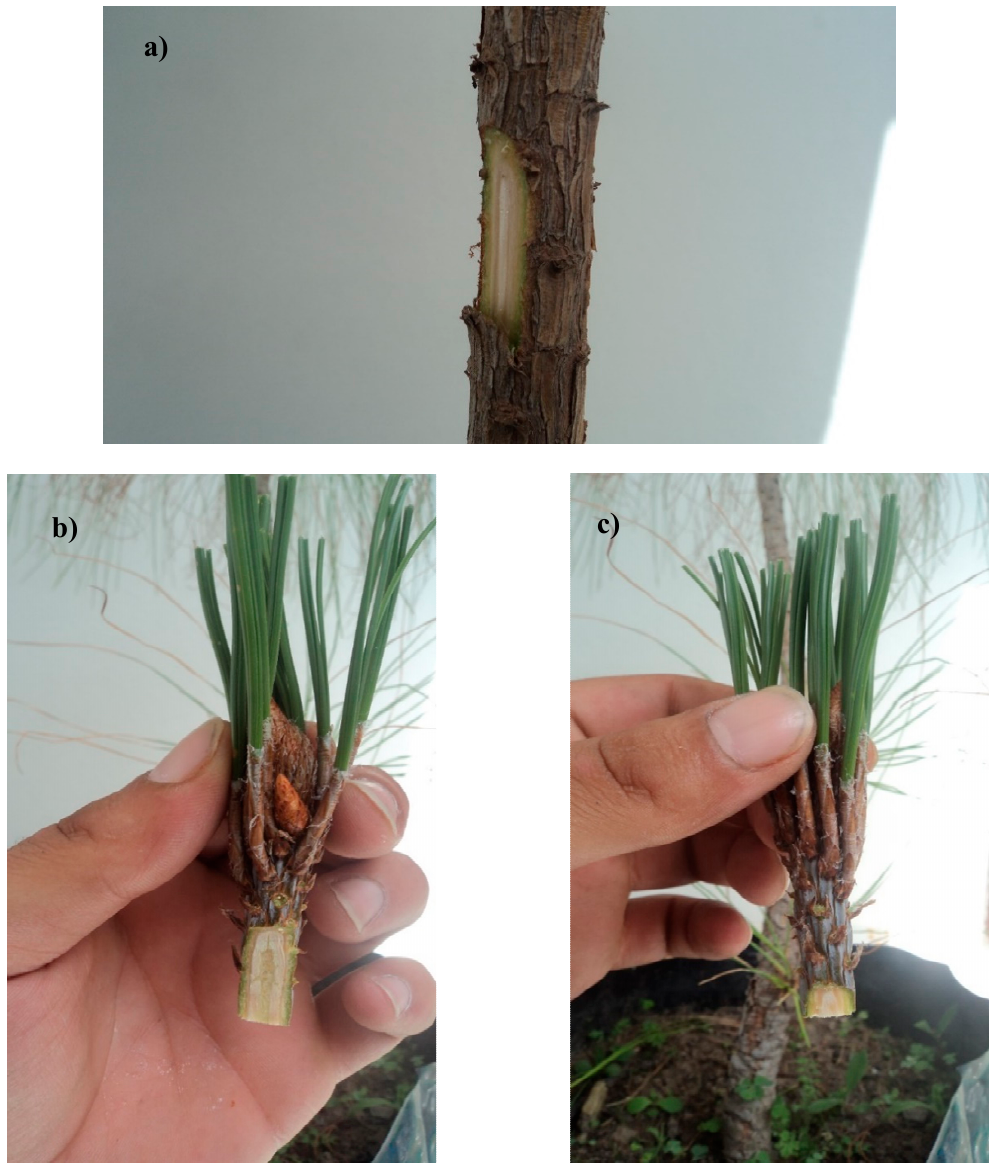
Figure 1. Cuts in rootstock and scion for grafting. ( a ) Longitudinal section in the rootstock with a slit at the lower end. ( b ) Long cut at the end of the scion that would be tied to the rootstock. ( c ) Small cut on the opposite side to the first cut, for insertion in the rootstock.